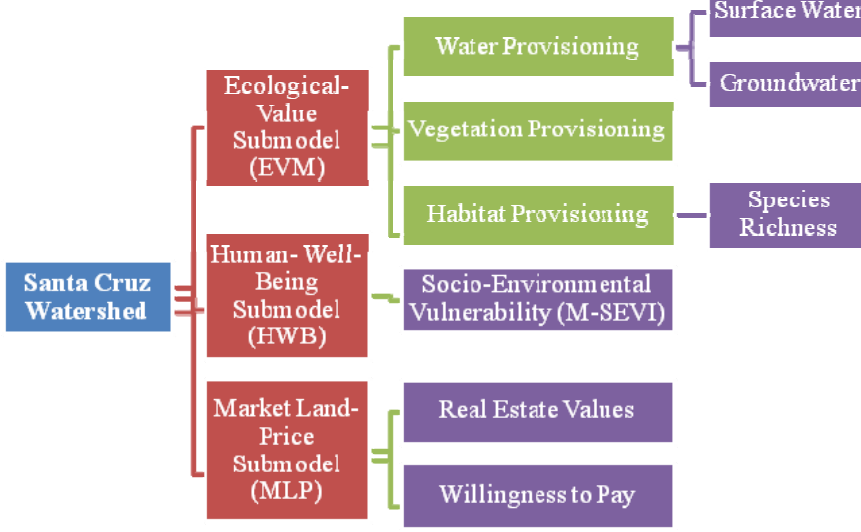
Figure 4. Conceptual graphic of the Santa Cruz Watershed Ecosystem Portfolio Model (SCWEPM), sub-models (in red boxes), ecosystem services (in green boxes) and quantifiable attributes (in purple